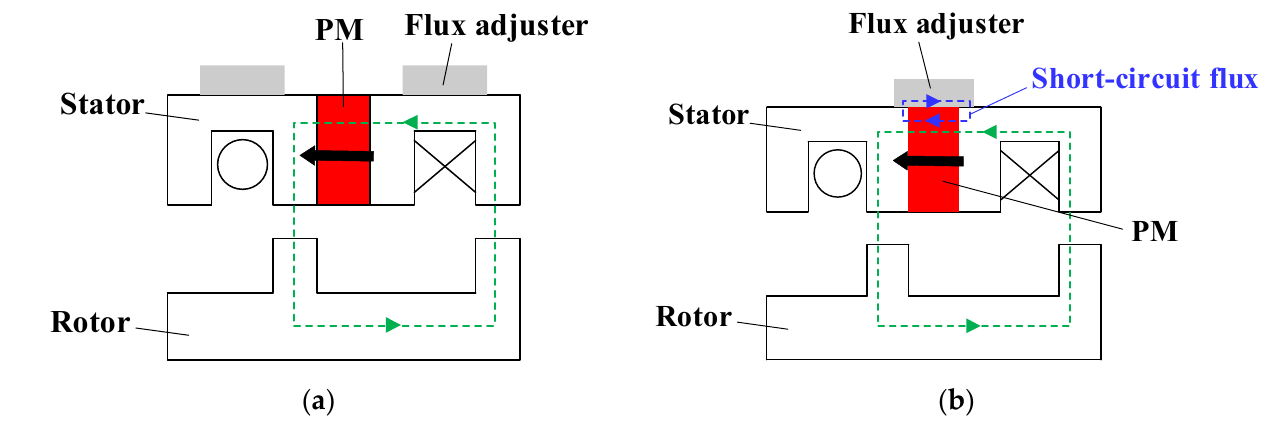
Figure 19. Illustration of the mechanism of the flux adjuster [66]. ( a ) Flux-enhancing state. ( b ) Flux- weakening